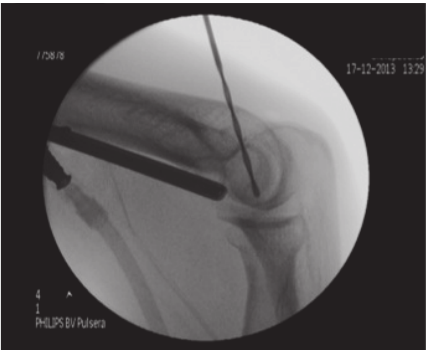
Figure 3: Radioscopic image of arthroscopic-assisted retrograde drilling of the